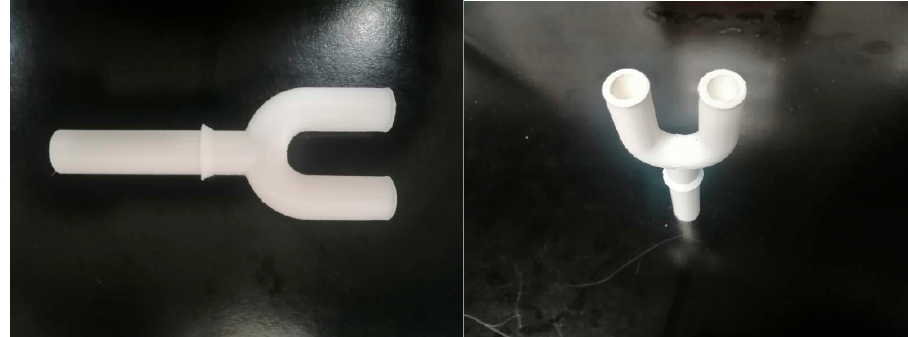
Figure 2. Photographic images of the Y shaped tube sampling port.